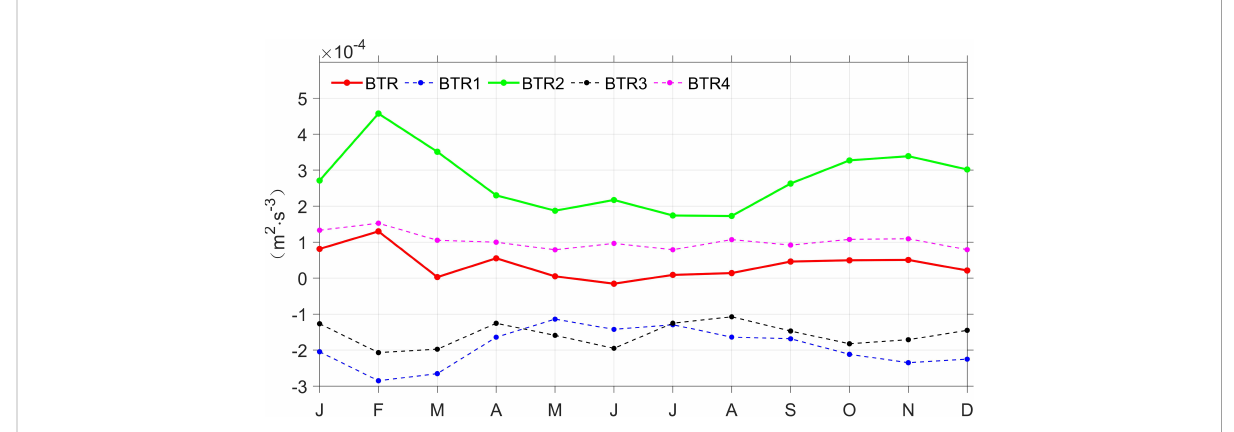
FIGURE 9 Seasonal variations of spatial mean BTR (red solid line), BTR1 (blue dash line), BTR2 (green solid line), BTR3 (black dash line), and BTR4 (magenta dash line) averaged over the upper 300 m layer from OFES during July 1999-October 2009 in the EAC region (148°E-160°E,